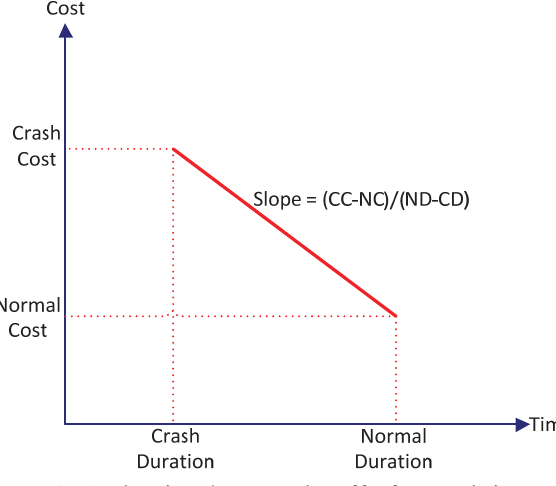
Fig.1. the time/cost trade-off of an